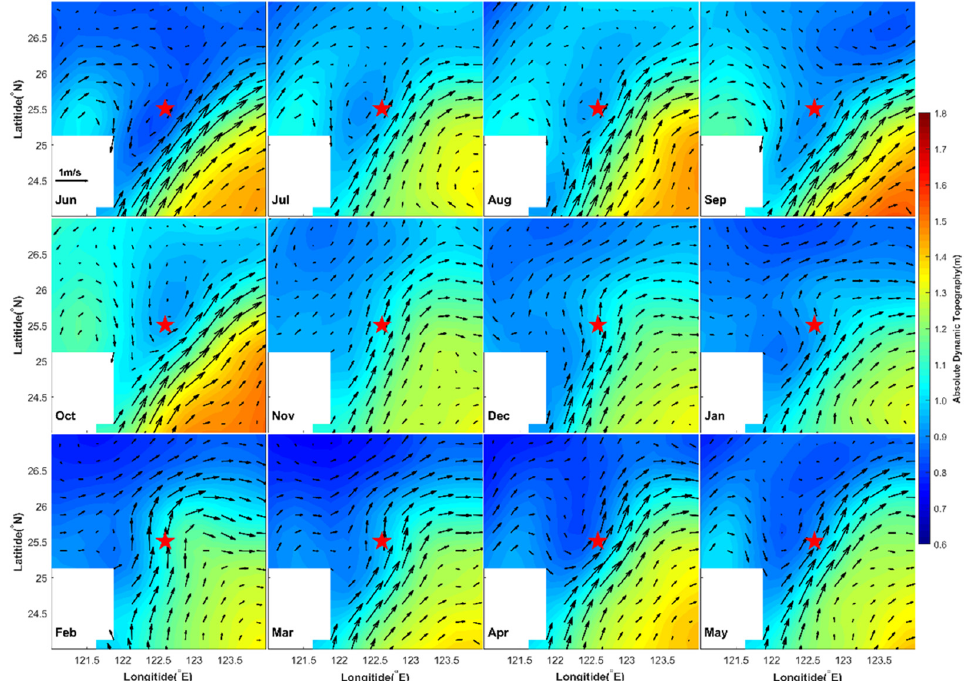
Figure 9. Monthly mean Absolute Dynamic Topography (color) and Geostrophic Currents (arrows) from June of 2017 to May of 2018 based on the AVISO dataset. The red pentagram denotes the location of the mooring.